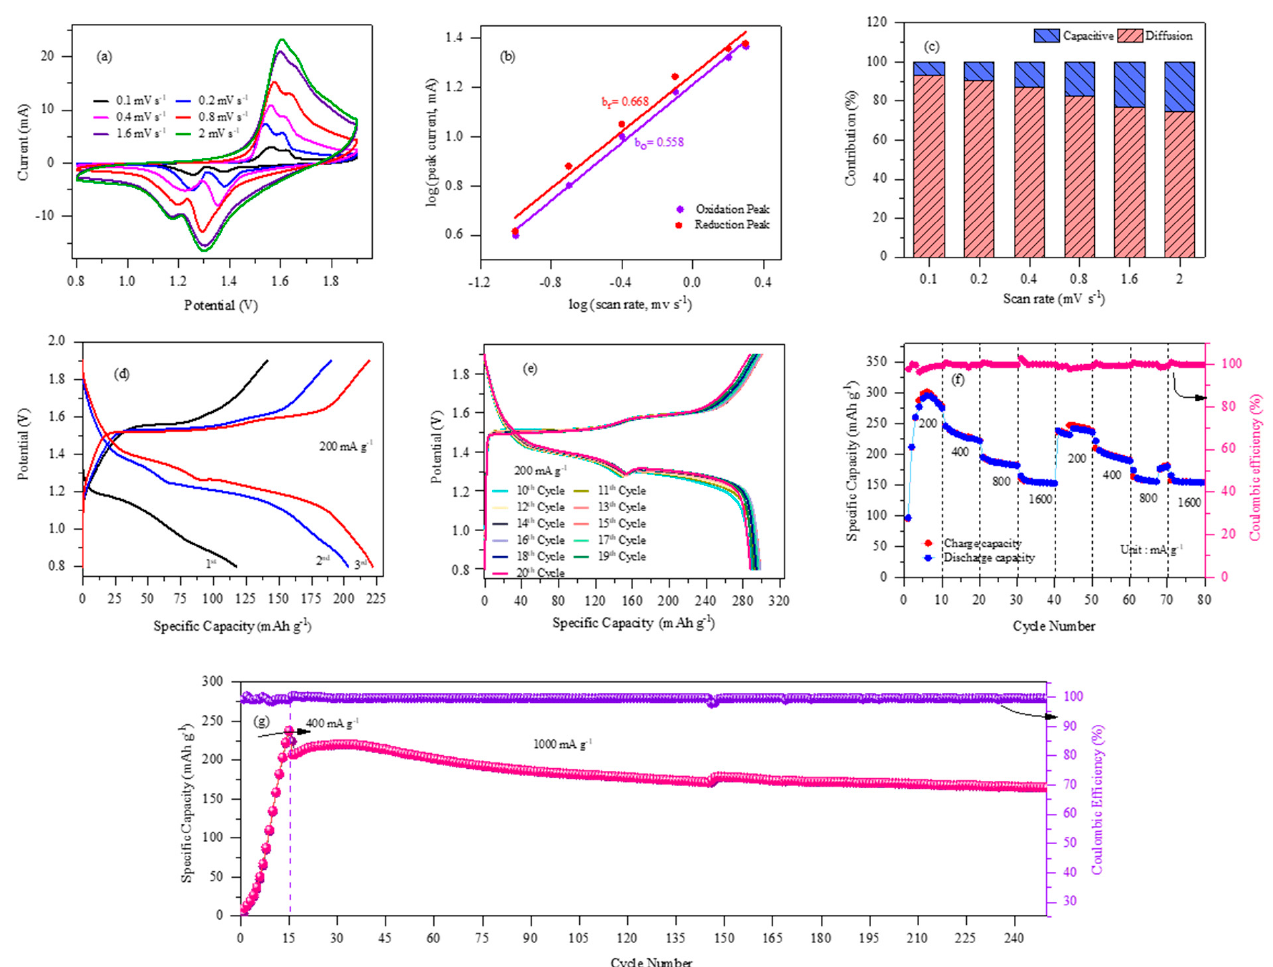
Figure 6. Electrochemical performances of δ− MnO 2 sample: ( a ) cyclic voltammetry curves at different current densities; ( b ) linear relationship between the logarithm of peak current and scan rates; ( c ) corresponding capacitive and diffusion contribution ratio to the total capacity of δ− MnO 2 sample; ( d,e ) galvanostatic discharge/charge curves at a constant current density of 200 mA g − 1 for initial three cycles and then, successive 20 cycles, respectively; ( f ) C-rate performances at various current densities; ( g ) long-term cycling performance at 1000 mA g − 1